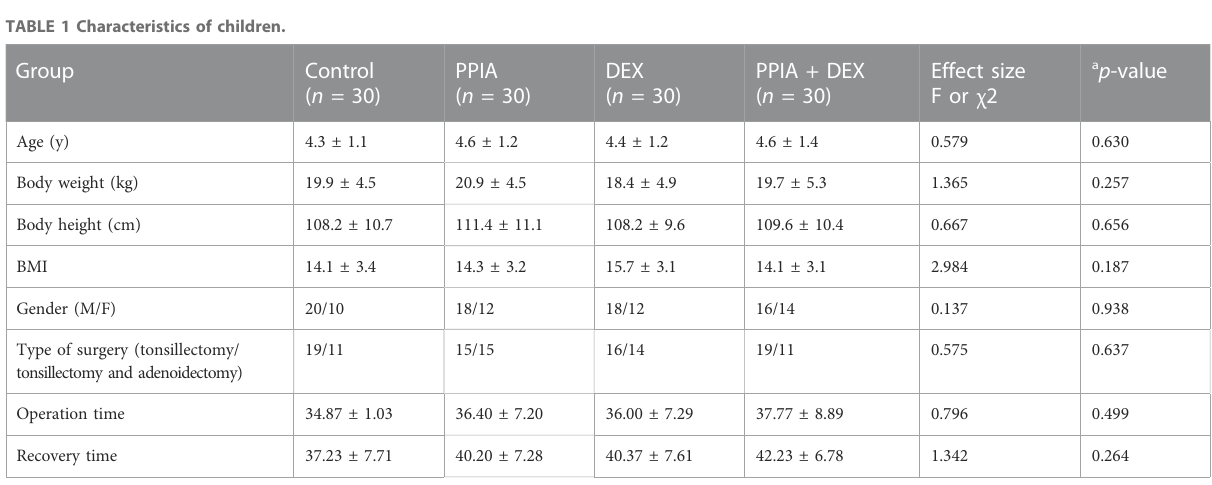
TABLE 1 Characteristics of